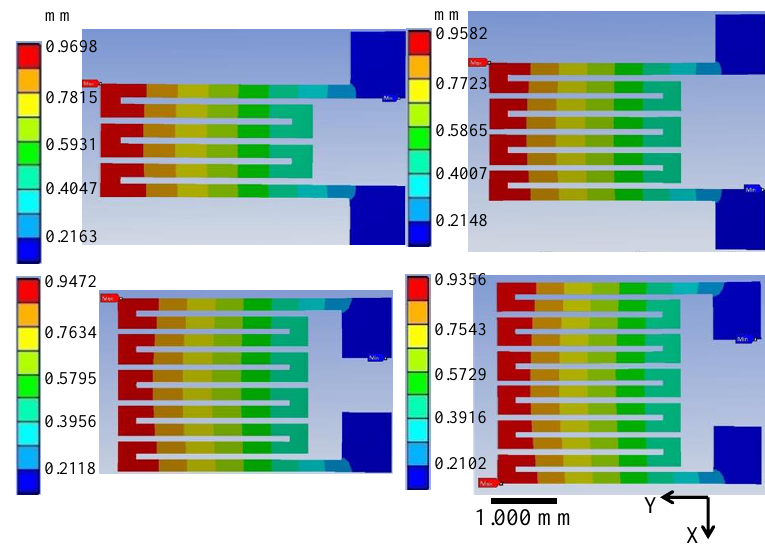
Figure 9. Total stretching and gauge factors of different gauge patterns were simulated with ANSYS.